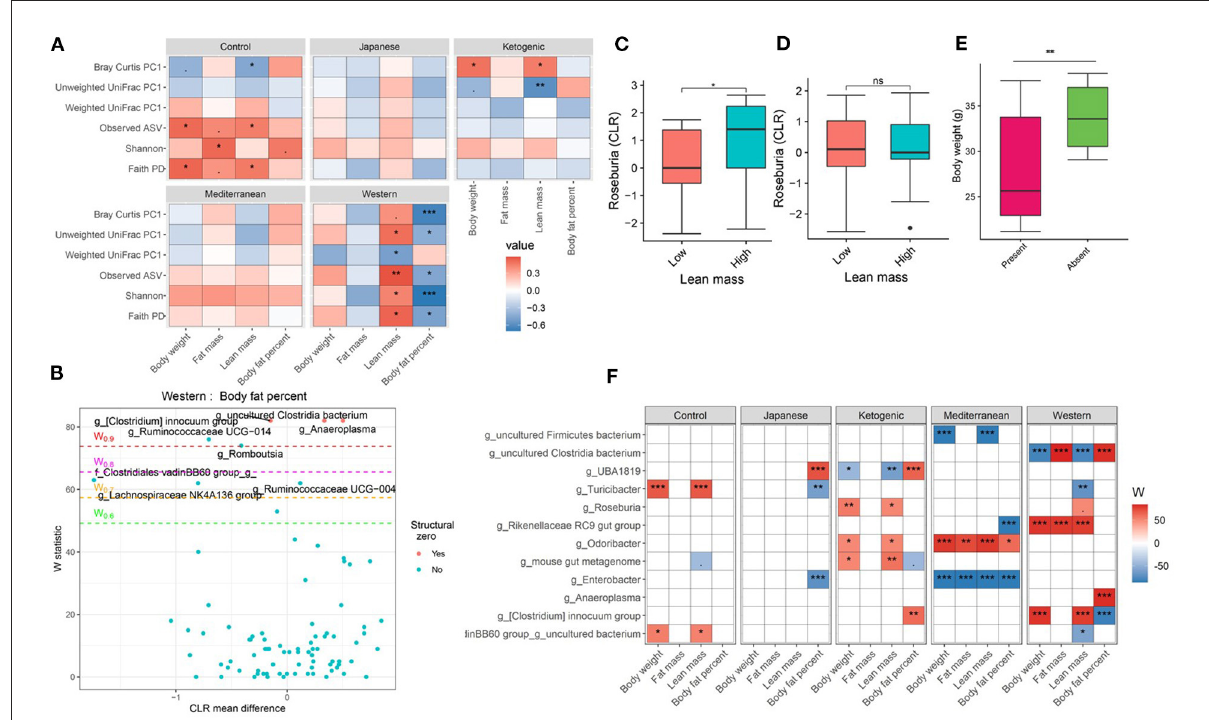
FIGURE3 Diet and gut microbiota interact to alter host body composition. (A) Association between body composition measures and α -diversity or first principal component (PC1) of β -diversity measured for each diet determined by using Spearman correlation. As indicated, red represents a positive correlation and blue represents a negative correlation. P -values were adjusted for multiple comparisons using BH method. “***” = adj. p < 0.001, “**” = adj. p < 0.01, “*” = adj. p < 0.05, and “.” = adj. p < 0.10. (B) Volcano plot of the differential genera abundance between high (above median) and low (below median) body fat percentage in mice maintained on western diet determined by ANCOM analysis. Structural zero represents the presence of the bacteria in one group and complete absence in another group. (C) Relative abundance of the Roseburia in mice having high and low lean mass maintained on the ketogenic diet. (D) Relative abundance of the Roseburia in mice with high and low lean mass maintained on the Mediterranean diet. (E) Bodyweight distribution of mice maintained on the Mediterranean diet by the presence or absence of Enterobacter in their gut microbiome. Mean abundance was compared using the Wilcoxon rank-sum test. For (C–E) “**” = P < 0.01, “*” = P < 0.05, and “ns” = not significant. (F) Differential genera abundance between high (above median) and low (below median) body composition measures determined by ANCOM analysis. 20 most differentially abundant (based on cumulative ANCOM W-value) were selected for the graph. For easier presentation, ANCOM W values were converted to negative if the CLR effect size is negative. Red indicates higher genera abundance in the above-median group and blue bacteria represents higher genera abundance in the below-median group. White represents a non-significant result obtained from ANCOM analysis. Models were adjusted for mouse strain and sex as confounding factors. The median was calculated for each diet. ANCOM models were FDR (BH-method) corrected for multiple comparisons and a significant sub-hypothesis test at a level of adj. P < 0.05 was counted toward W value. For (F) , “***” = ≥ W 0.9 , “**” = ≥ W 0.8 , “*” = ≥ W 0.7 , and “.” = ≥ W 0.6